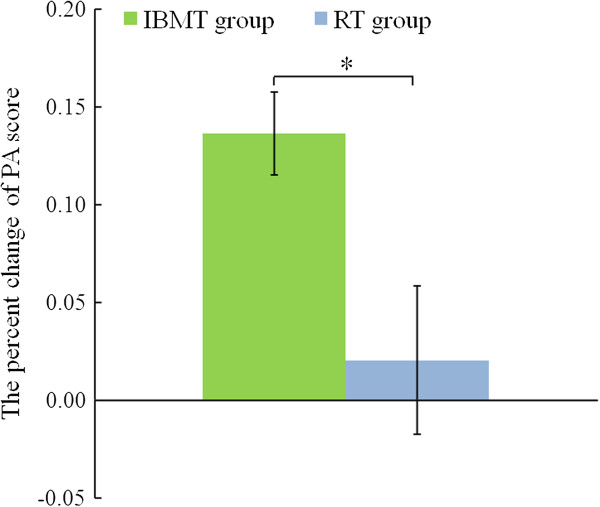
Comparison of the percent change of PA from pre to post between IBMT group and RT group. IBMT group (green bar). RT group (blue bar). *p < .05. Error bars indicate 1 SE. A higher vertical axis indicates a larger improvement of mood state.